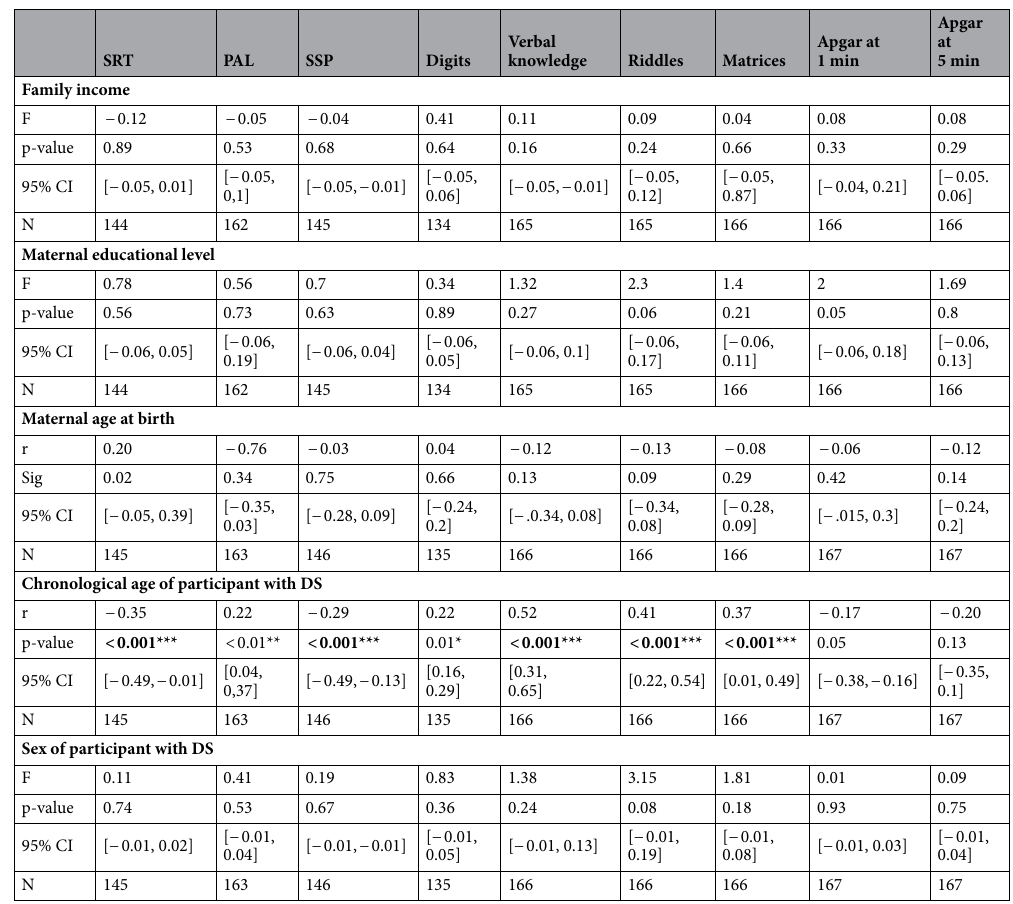
Table 3. Association between Apgar scores and cognitive outcomes with each of the potential covariates. r coefficient of correlation, F ANOVA F-value, 95% CI 95% Confidence Intervals, N sample size, SRT simple reaction time: median latency in milliseconds, PAL paired-associates learning: first trial memory score, SSP spatial span Forward: total errors adjusted; Recall of Digits Forward (Digits), Verbal Knowledge, Riddles and Matrices total number correct. Bolded p-values are those which remained significant after correcting for multiple comparisons (p <